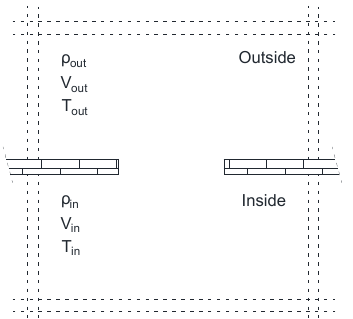
Figure 6. The horizontal opening investigated by De Jong [20].